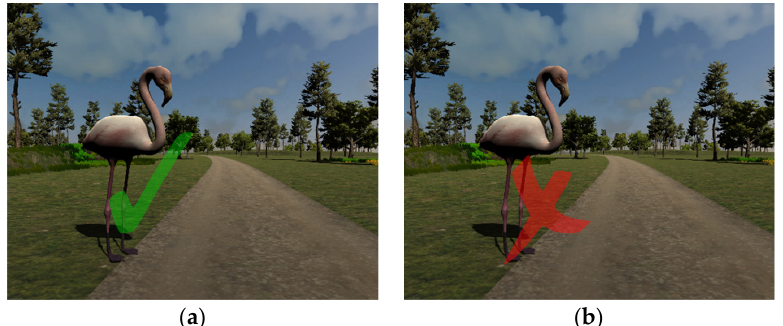
Figure 6. Examples of correct ( a ) and wrong ( b ) choice feedback to a user’s selection.